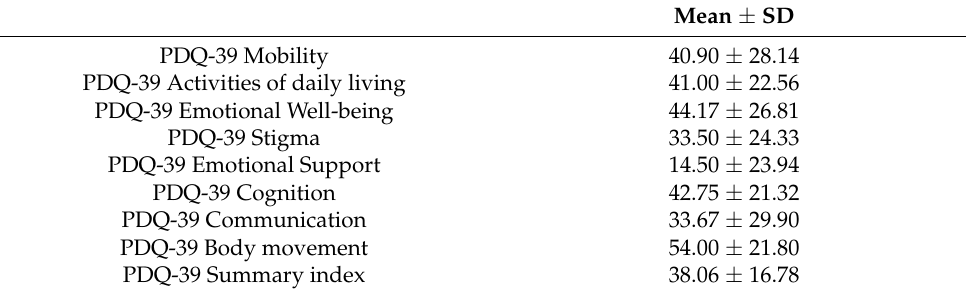
Table 2. Parkinson’s Disease Questionnaire-39-dimension